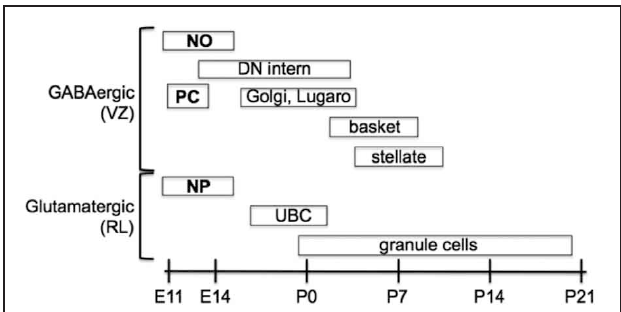
FIGURE 2 | Temporal sequence of birth for the main types of neurons that populate the adult cerebellum. Projection neurons are in boldface, interneurons are in normal text. Projection neurons of the cerebellar nuclei and cortex are the first to be born at the outset of cerebellar neurogenesis. These include glutamatergic nuclear projection neurons (NP) derived from the rhombic lip (RL) and GABAergic nucleo-olivary projection neurons (NO) and Purkinje cells (PC) derived from the ventricular zone (VZ). Local interneurons (of both neurotransmitter phenotypes) are born during late embryonic and early postnatal development. GABAergic interneurons are generated according to an inside-out sequence, occupying the deep nuclei first, and then the granular and molecular layer [Modified from Carletti and Rossi